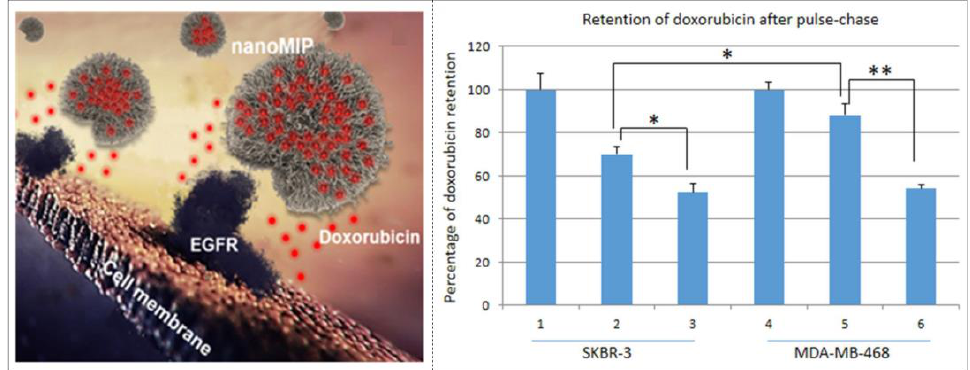
Figure 11. Double-imprinted MIP-NPs are loaded with adriamycin and target linear epitopes of EGFR ( left ); e retention of doxorubicin after pulse-chase in SKBR-3 and MDA-MB-468 cells. * p < 0.05, ** p < 0.01. ( right ). Reprinted with permission from Ref. [155]. Copyright 2018, ACS.